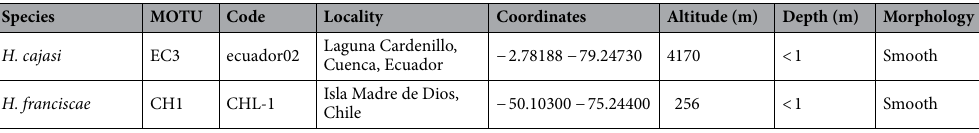
Table 1. Taxa included in the analysis. Details on their putative taxonomic placement, mitochondrial Molecular Operational Taxonomic Units (Jurado-Rivera et al. 15 ) and geographic origin are